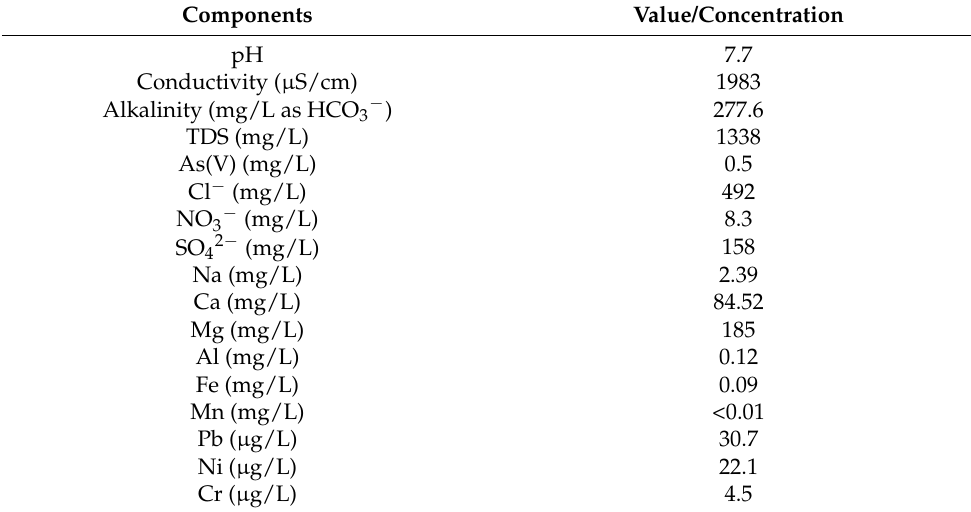
Table 3. Characterization of arsenic polluted groundwater well used for the